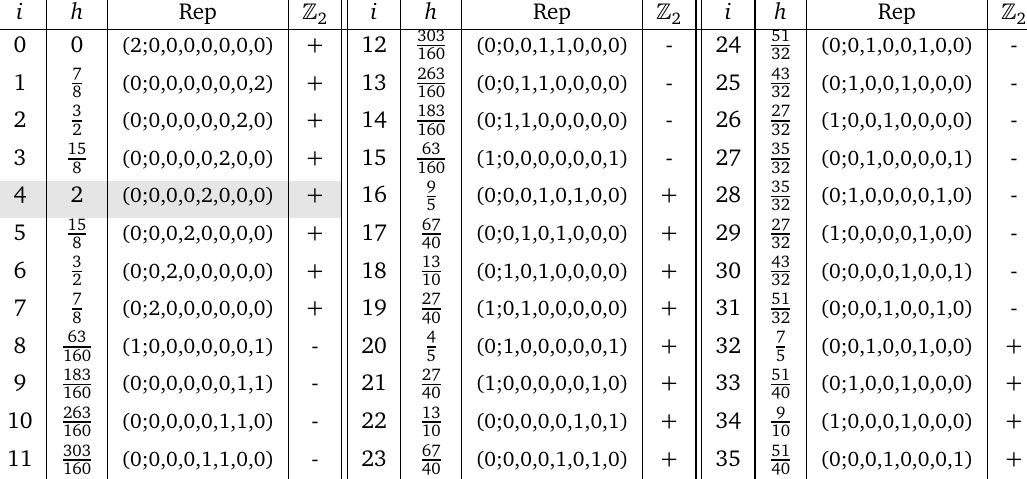
Table 22: SU ( 8 ) : primaries labeled by i are characterized by weights h and SU ( 8 ) Dynkin 2 labels. Their characters are denoted by χ symmetry (cid:90) . 2